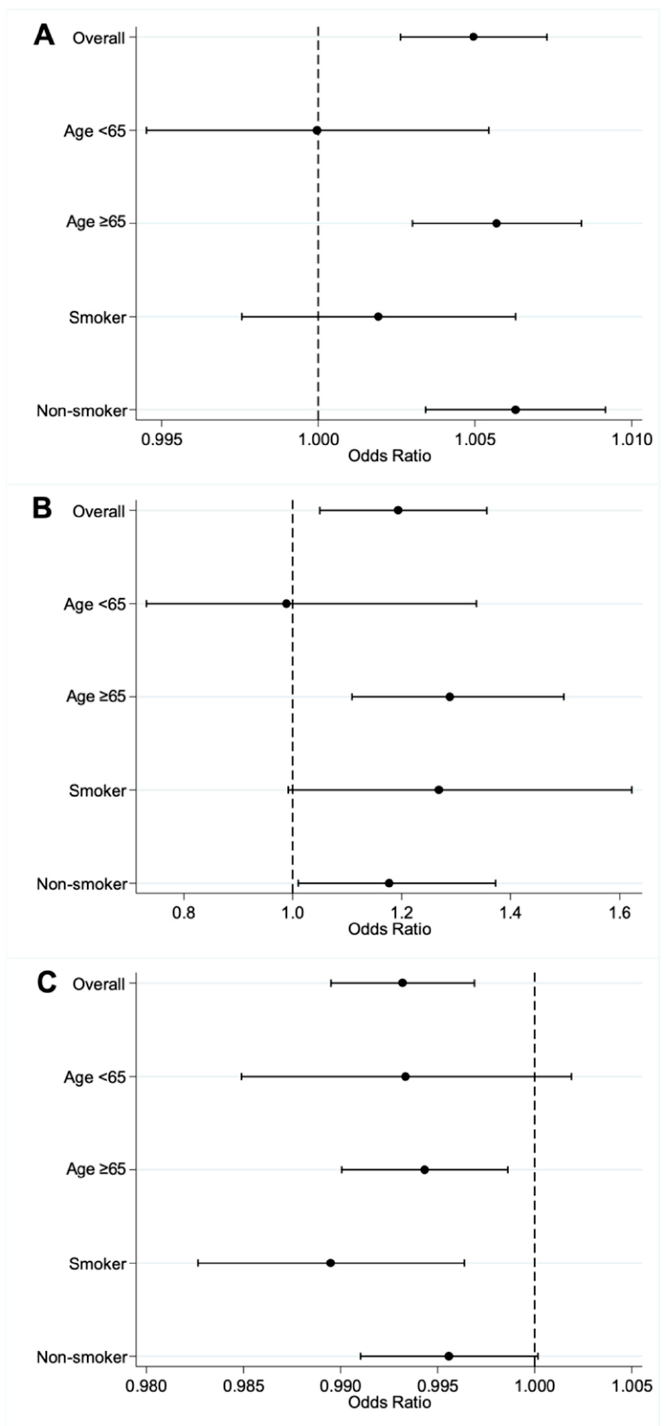
Figure 2. Adjusted odds ratio of AIS for ( A ) O 3 exposure, ( B ) CO exposure, and ( C ) SO 2 exposure among all and subgroups of patients with AF compared to those without AF.